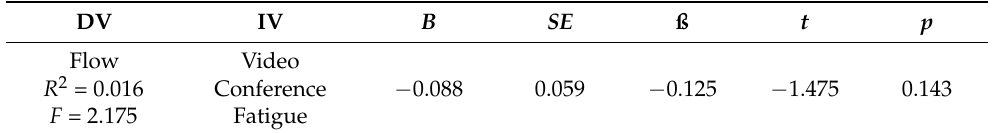
Table 10. Results of multiple regression using video conference fatigue to predict video confer- ence